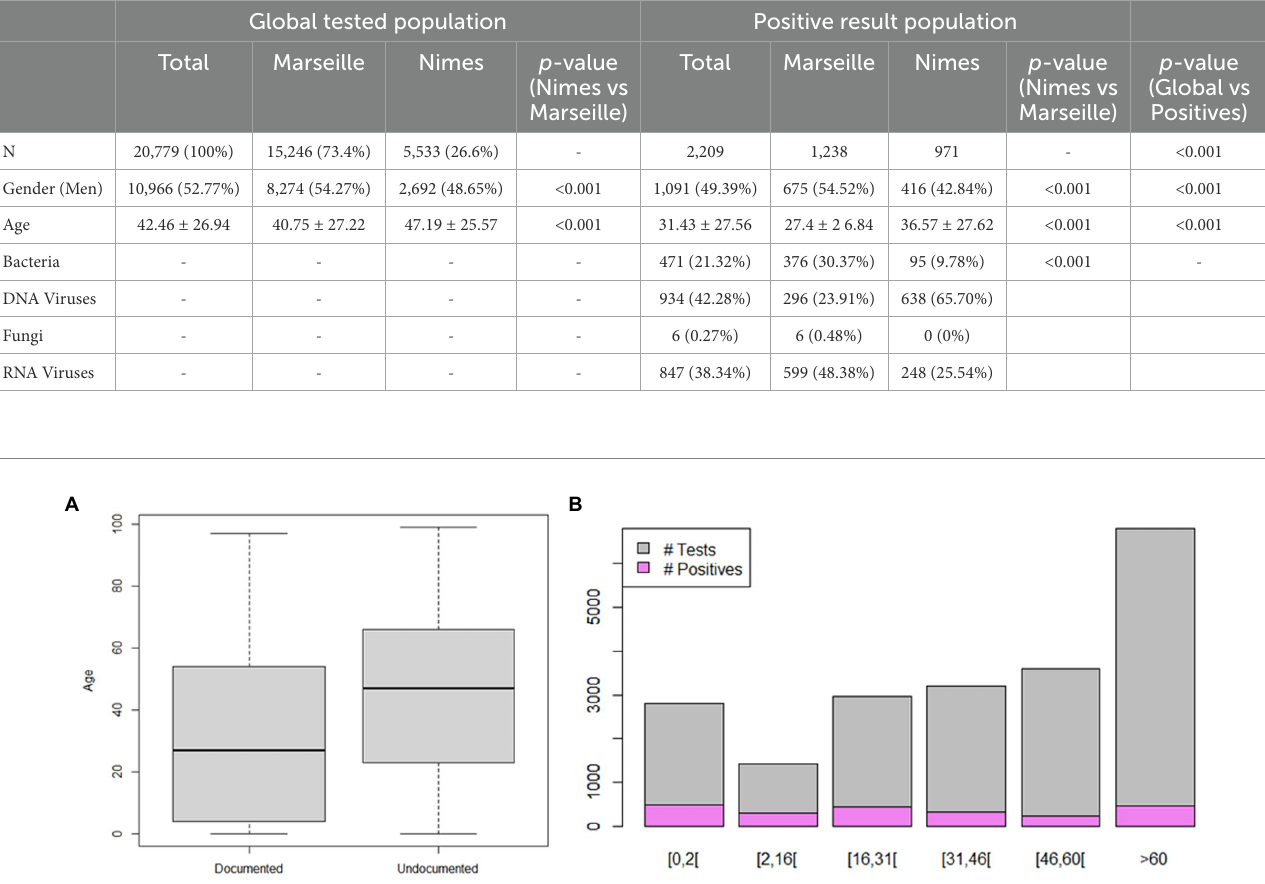
TABLE 1 Summary statistics for the age and gender variables, comparisons according to city and positive/negative status.